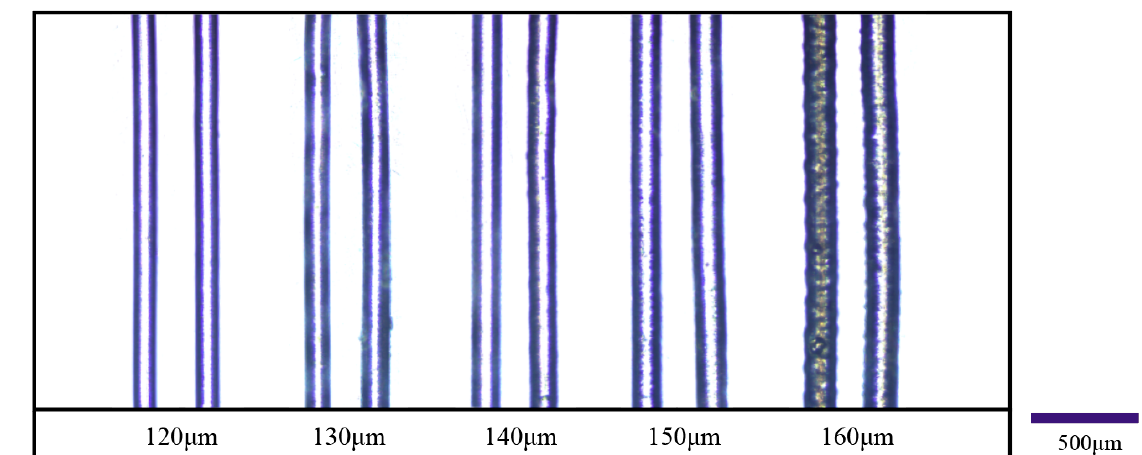
Figure 9. Printed filaments of PLCL with designed process parameters.